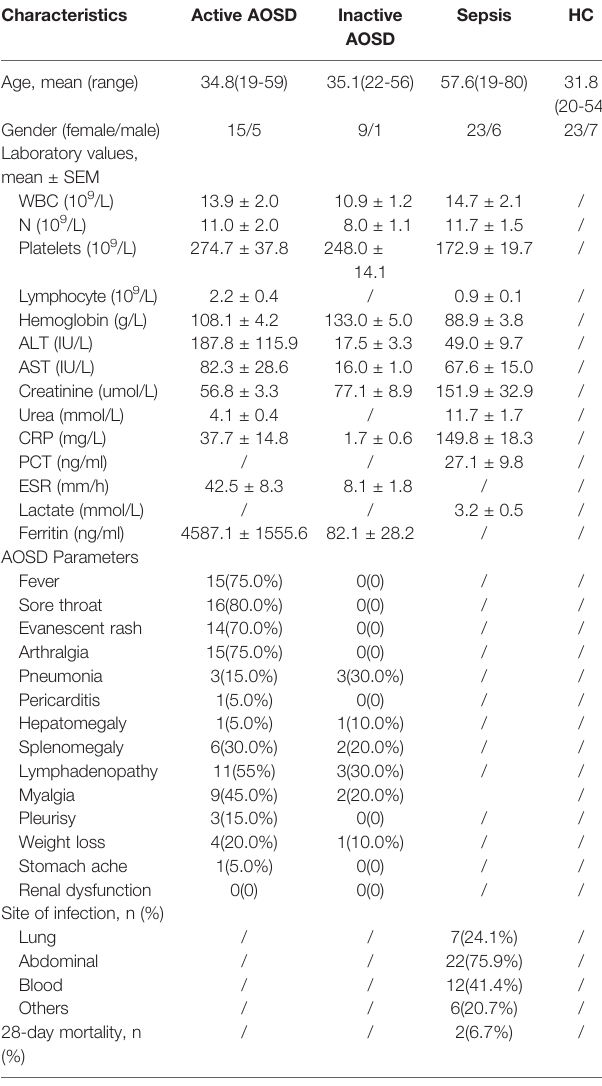
TABLE 1 | Characteristics of people with adult-onset Still ’ s disease (AOSD) and those with sepsis and healthy controls included in this study. Characteristics